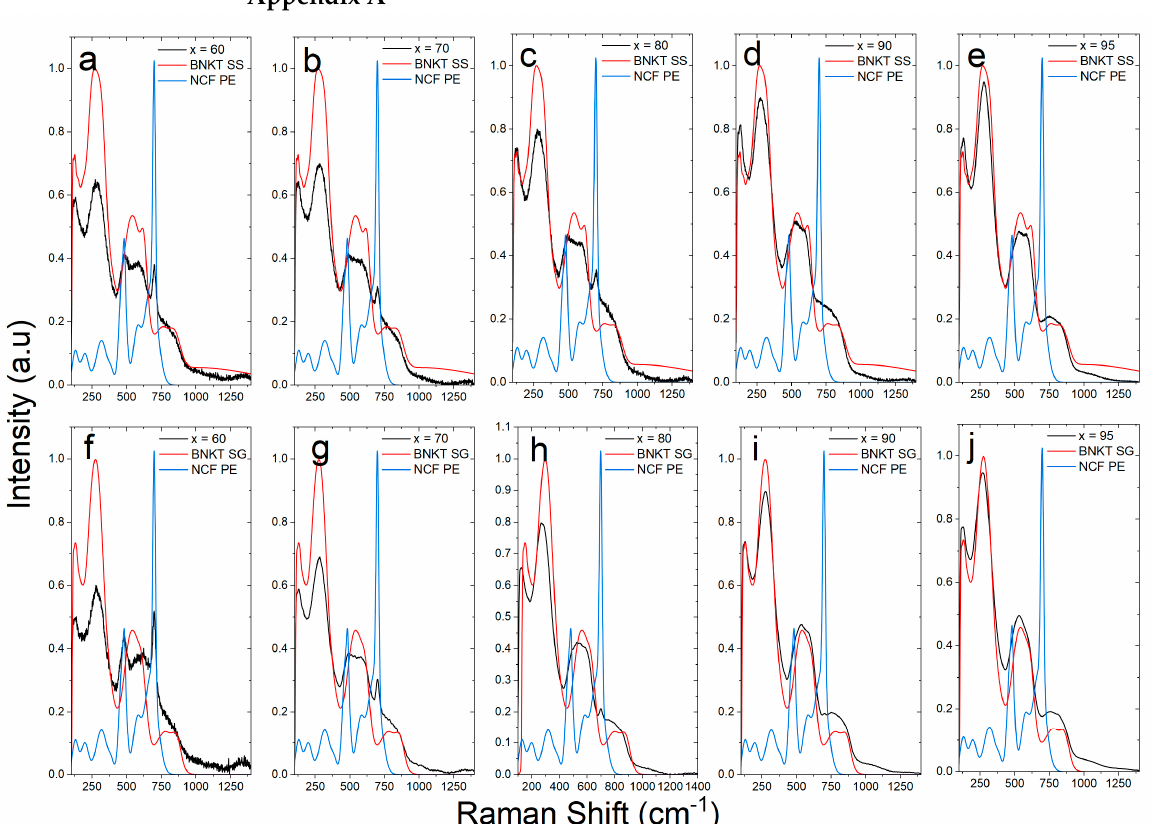
Figure A1. Experimental and calculated Raman spectra of xBNKT-(100-x)NCF (x = 100, 95, 90, 80, 70, 60, 0) SS-SS ( a – e ) and SG-PE ( f – j ) sintered samples.